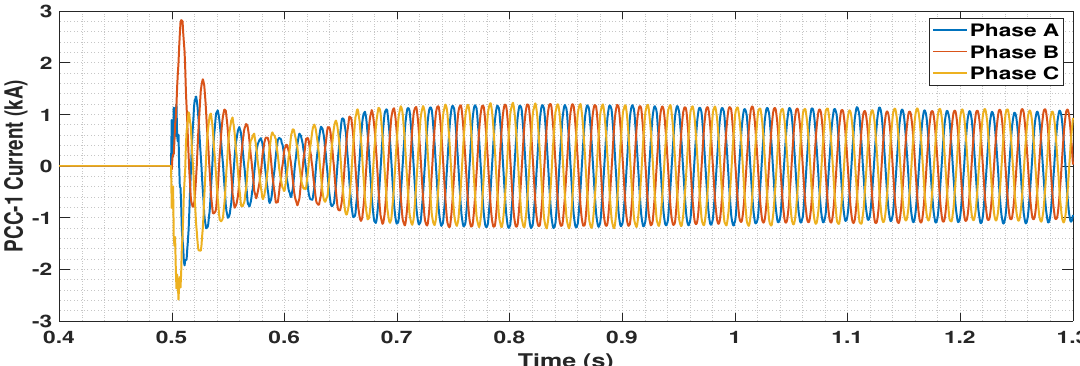
Figure 21. Currents in PCC-1 upon connecting OWF-1 with 50 MW generation to the